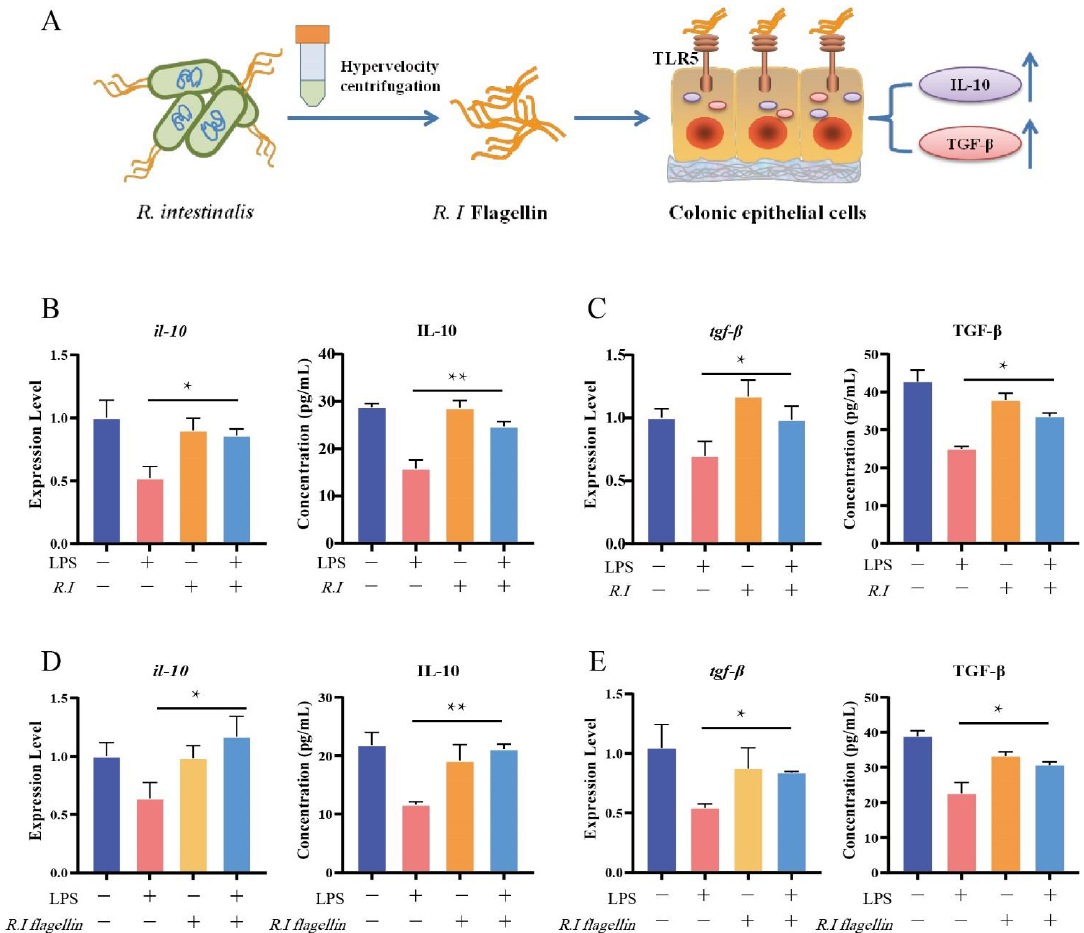
Figure 2. LPS-induced inflammation in HT29 cells ameliorated by R. intestinalis and flagellin of R. intestinalis . ( A ) Colonic epithelial cells with the TLR5 receptor recognize R. intestinalis flagellin and secrete the anti-inflammatory factors IL-10 and TGF- β. RT‒qPCR and ELISA analysis of IL -10 ( B ) and TGF- β ( C ) mRNA and protein levels in the control, LPS, R. I , and LPS + R. I treated HT29 cells. RT‒qPCR and ELISA analysis of IL -10 ( D ) and TGF- β ( E ) mRNA and protein levels in control, LPS, flagellin, and LPS + R. I flagellin treated HT29 cells. The results are presented as the mean ± SD of three replicates; * p < 0.05 and ** p < 0.01.